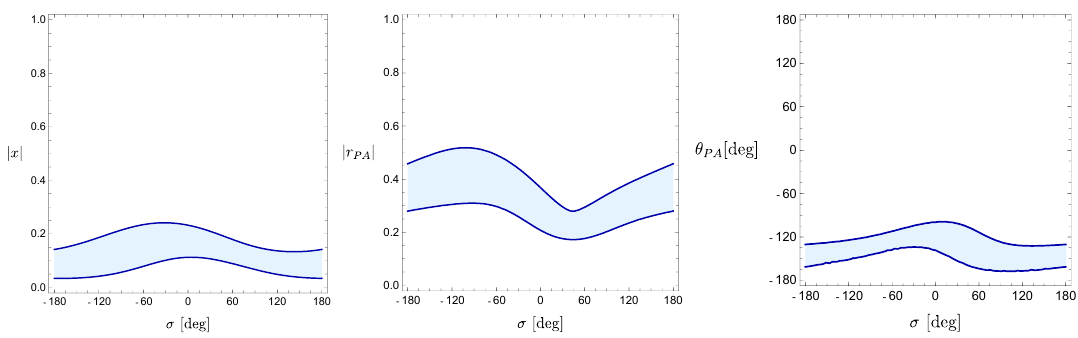
Figure 3 . The allowed 1 σ regions from current data for different combinations of the exchange ( x, σ ) and penguin-annihilation ( r PA , θ PA )